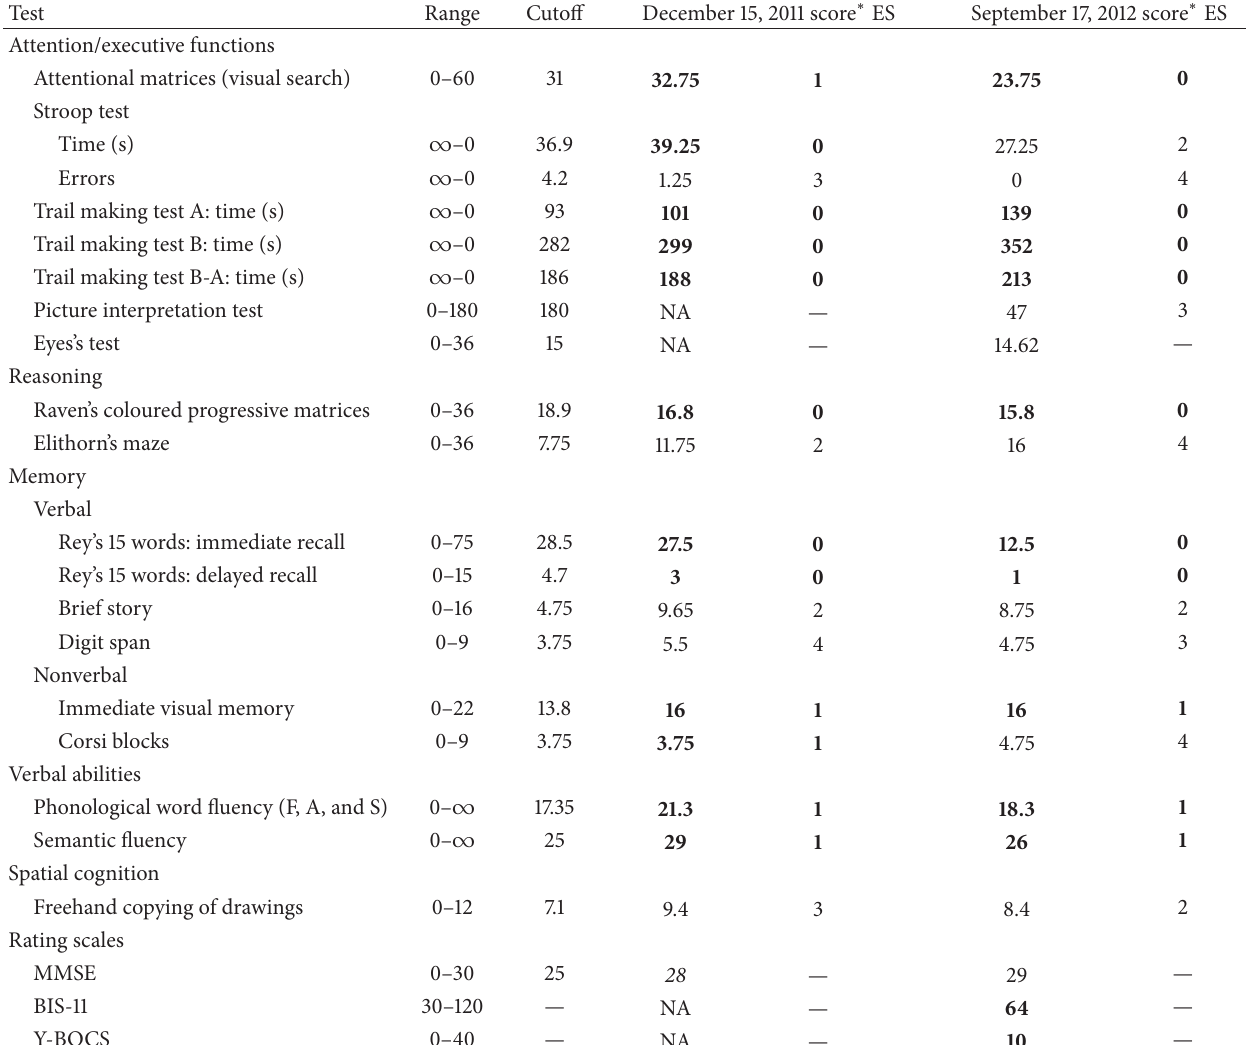
Table 1: Neuropsychological